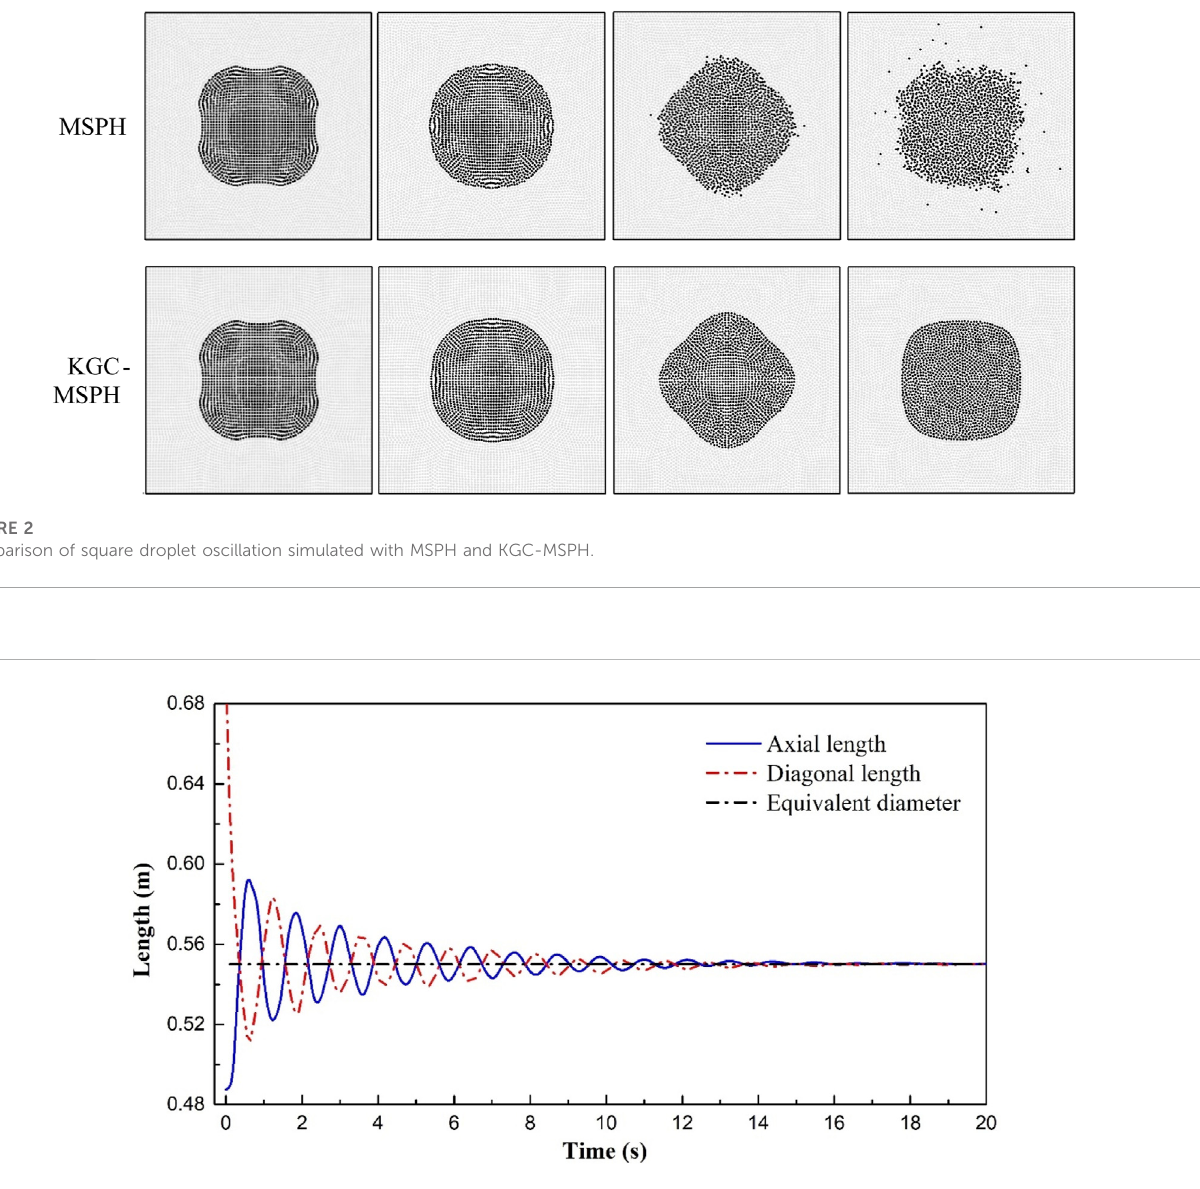
FIGURE 3 The variation of axial and diagonal sizes of the droplet.